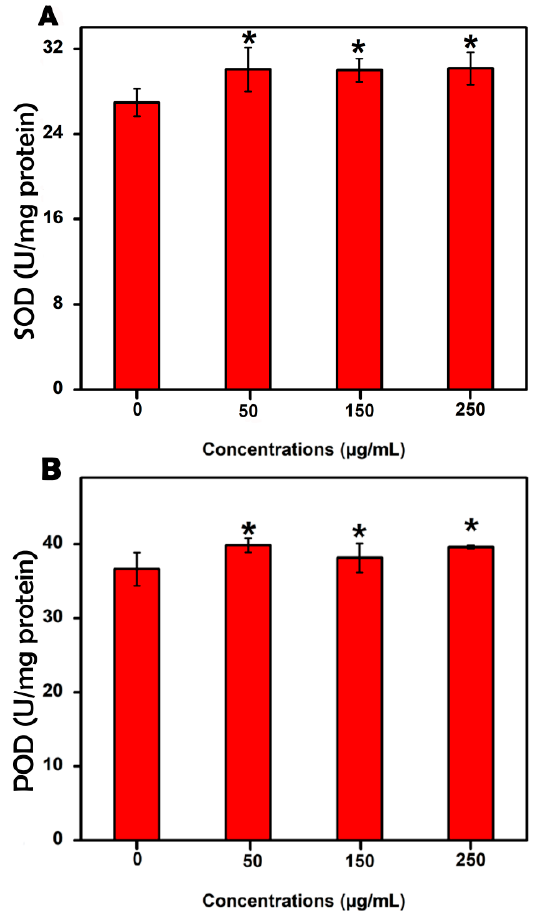
Figure 3. Effect of the MgONPs on the antioxidant system, ( A ) SOD activities, and ( B ) POD activities. Error bars represent the standard deviation, * p < 0.05.